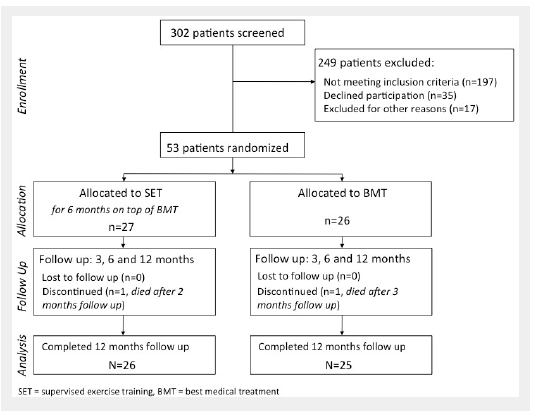
CONSORT flow diagram. * Reasons for exclusion: 15 patients were enrolled in another clinical trial and two patients deteriorated prior to randomization and underwent revascularization.